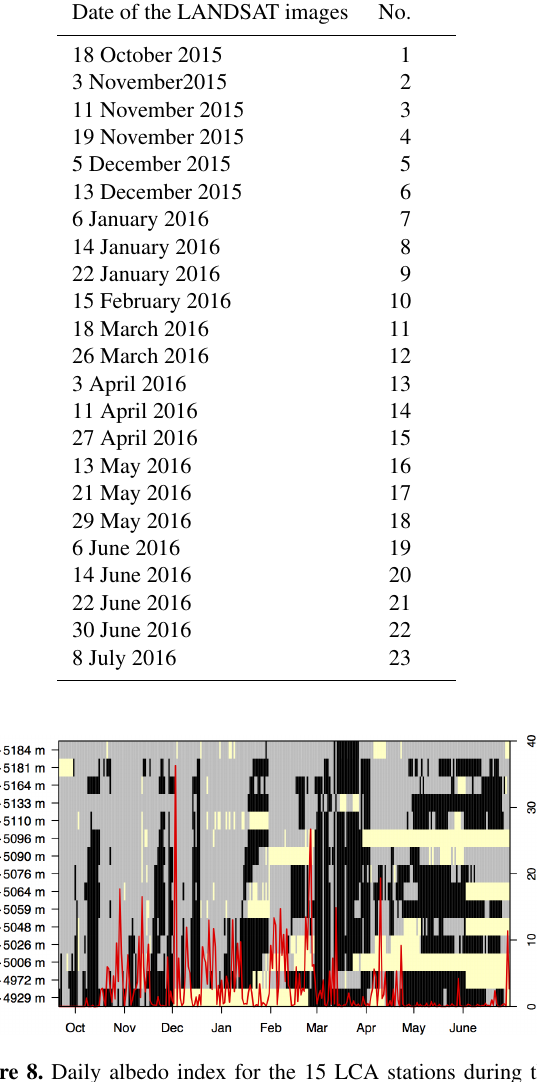
Figure 8. Daily albedo index for the 15 LCA stations during the period from 21 September 2015 to 30 June 2016. In yellow: miss- ing data; binary values considering the separation between ice (1: in black) and snow (2: in grey) with a threshold equal to 0.39. In red: the daily precipitation amount measured by the GEONOR rain gauge at the ORE station (mmday − 1